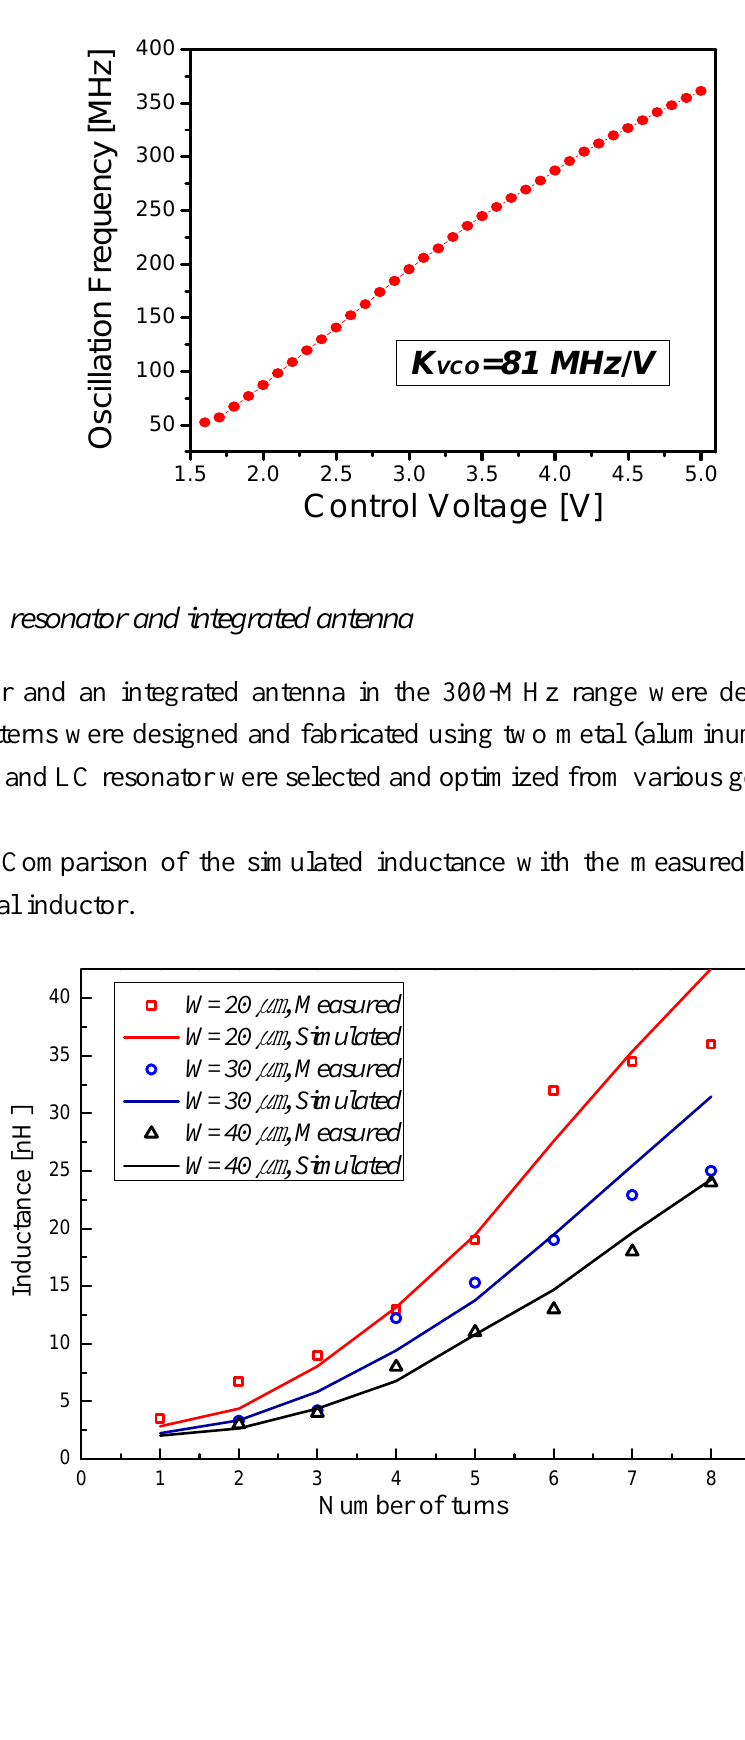
Figure 5 . Measured relationship between oscillation frequency and control voltage of fabricated VCO. The K is extracted from this measured relationship. VCO